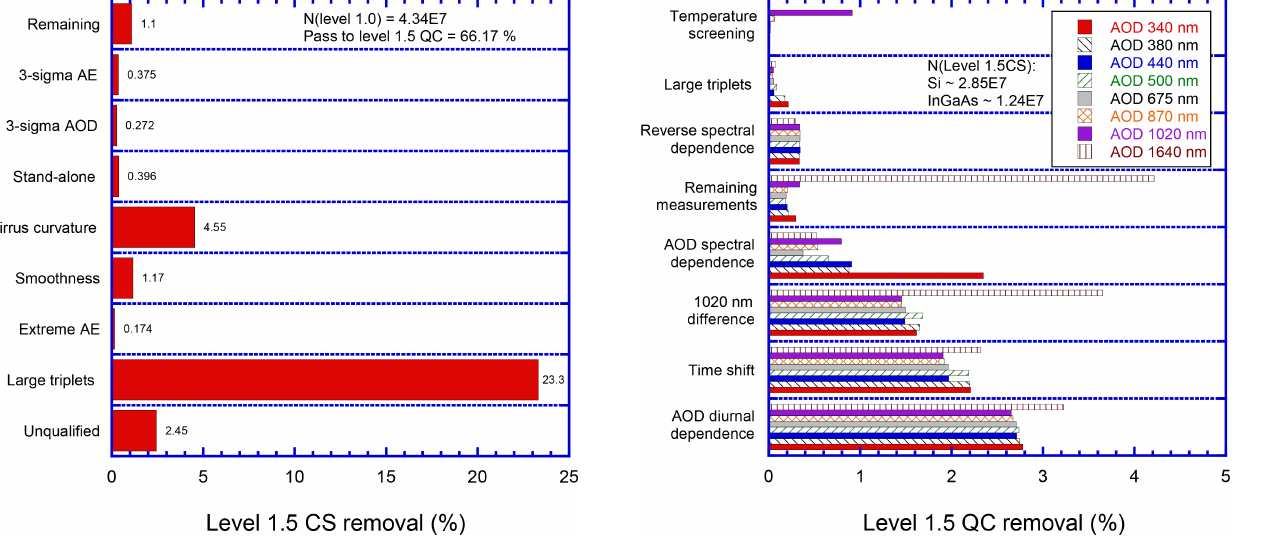
Figure 17. Level 1.5 quality control algorithm wavelength- dependent impacts for each major step for the period analyzed from 1993 to 2018. The most significant removal for most chan- nels is due to AOD diurnal dependence, time shift, and differ- ence between AOD at 1020nm for the silicon and InGaAs detec- tors (resulting from collimator inconsistency). The AOD at 340nm has significant removal of AOD spectral dependence. The 1640nm InGaAs channel has significant removal by “remaining measure- ments” since this wavelength cannot be checked for quality when the silicon channels are not available. Temperature screening mostly applies to the 1020nm silicon wavelength due to its strong tempera- ture dependence near the edge of the signal sensitivity of the silicon photodiode